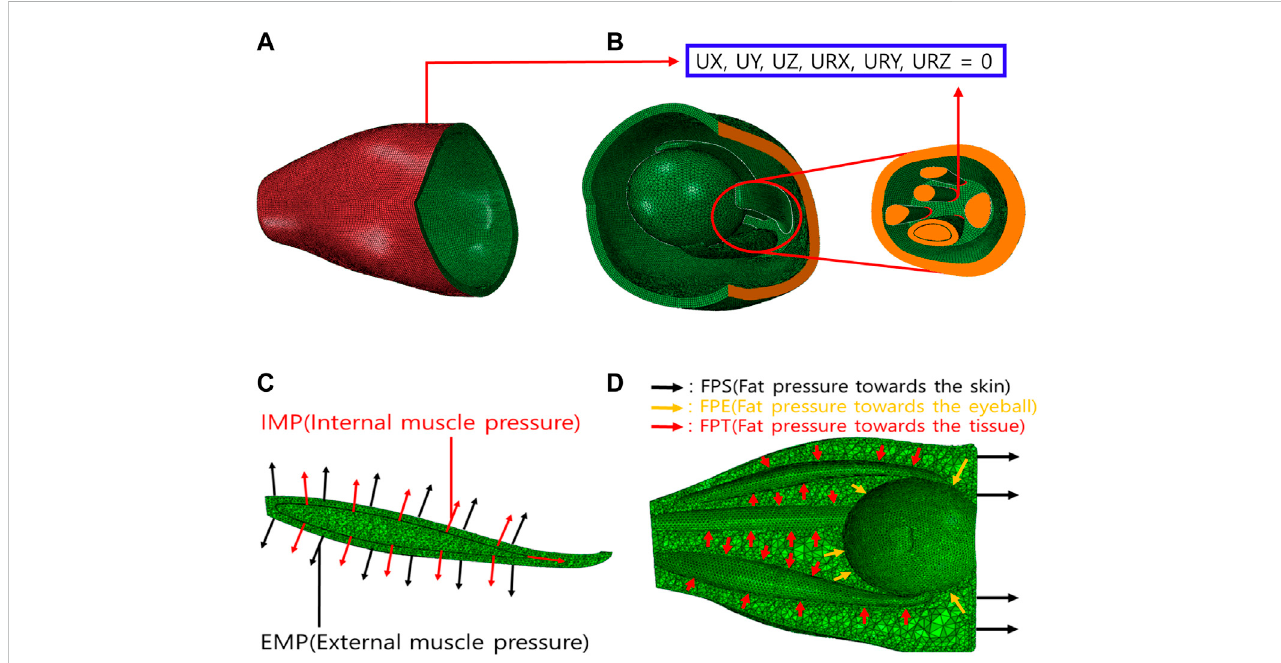
FIGURE 3 Boundary and load conditions of fi nite element model. (A) Orbital outer wall boundary conditions for movement restriction. (B) Boundary conditions of intraorbital. (C) Loading conditions of IR hypertrophy. (D) Loading conditions of elevated intraorbital pressure